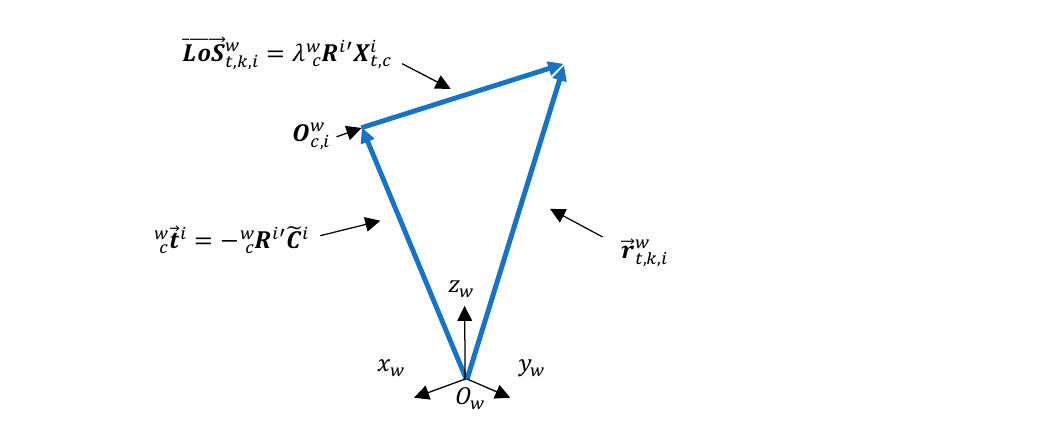
w → ( λ ) from Camera 1 to the r 1, k ,1